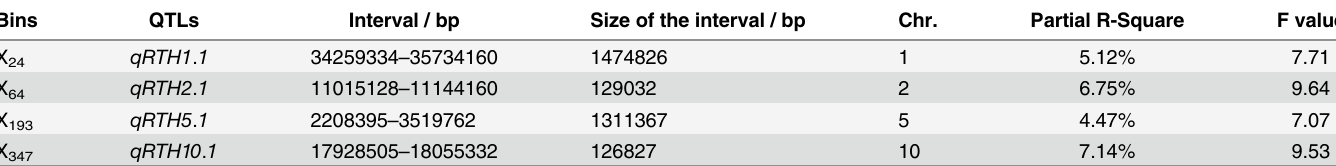
Table 8. QTLs mapping of RTH.